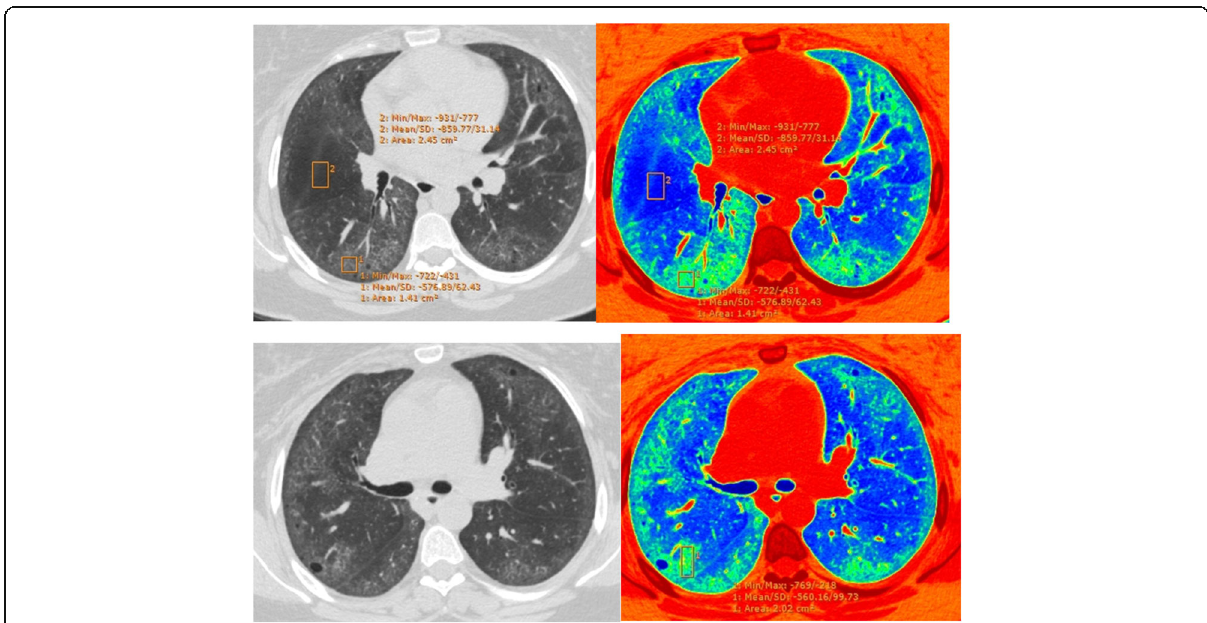
Fig. 7 A 38-year-old female patient, presented with collagen vascular disease and progressive dysnea. Diagnosed as LIP. HRCT axial lung and color-coded density images showing bilateral fairly symmetrical subpleural ground glass opacification and reticulation with few scattered cysts. Color-coded images allowed better evaluation of areas reticulation and ground glass (green color) for HU above − 750 and blue color for normal lung ranging between − 750 and − 900